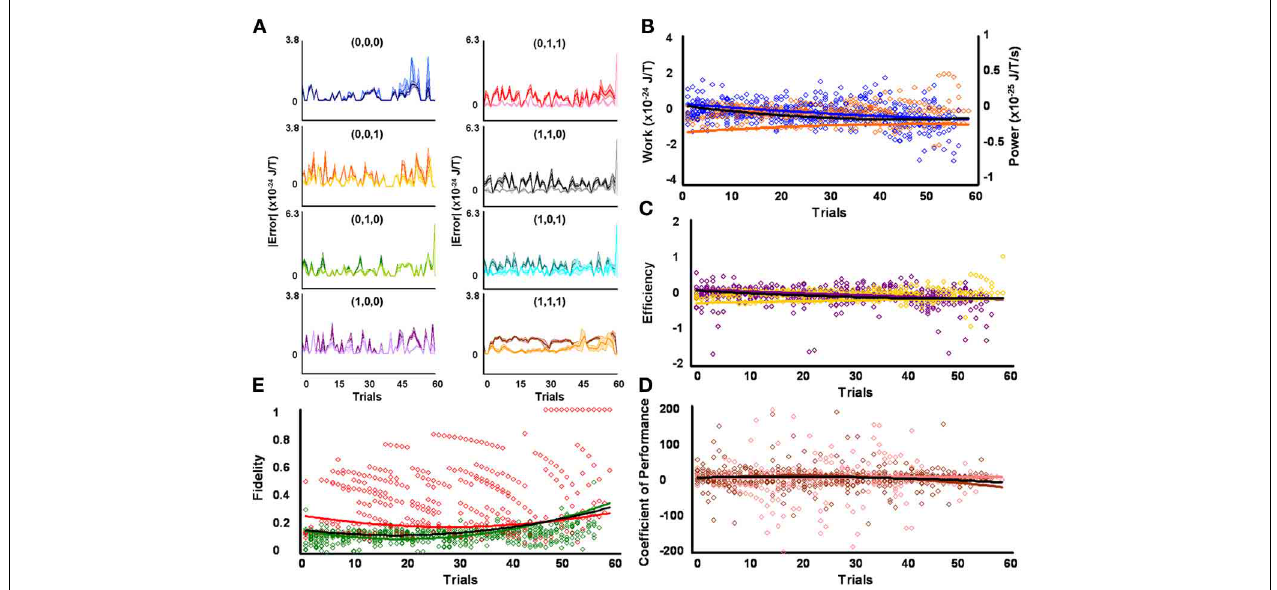
FIGURE 5 | Initial medium responders learn to diagnose and correct classical errors in executed reversal strategies signaling mating fitness. (A) Repetition coding prevented errors in executed serial reversal signals from exceeding estimated single bit-flip errors in absolute mean average Boltzmann entropy [executed (light blue) and bit-flipped (dark blue) strategy (0,0,0), executed (light orange) and bit-flipped (dark orange) strategy (0,0,1), executed (lime green) and bit-flipped (green) strategy (0,1,0), executed (lavender) and bit-flipped (purple) strategy (1,0,0), executed (pink) and bit-flipped (red) strategy (0,1,1), executed (gray) and bit-flipped (black) strategy (1,1,0), executed (turquoise) and bit-flipped (teal) strategy (1,0,1), executed (gold) and bit-flipped (brown) strategy (1,1,1)]. (B) Differences in mean average Boltzmann entropy between strategy planning and execution stages were expelled by ciliates when learning to detect and correct errors in modal (orange) and non-modal (blue) serial reversal signals. Negative trends in work and associated power functions show that serial strategies